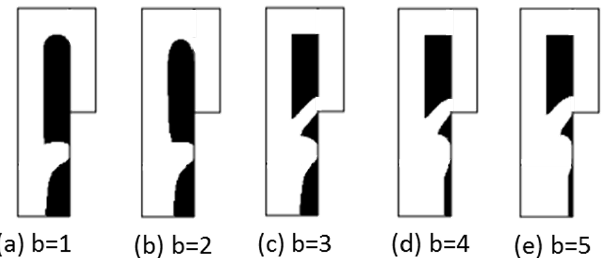
Figure 2. The optimization results with different volume coefficients b.